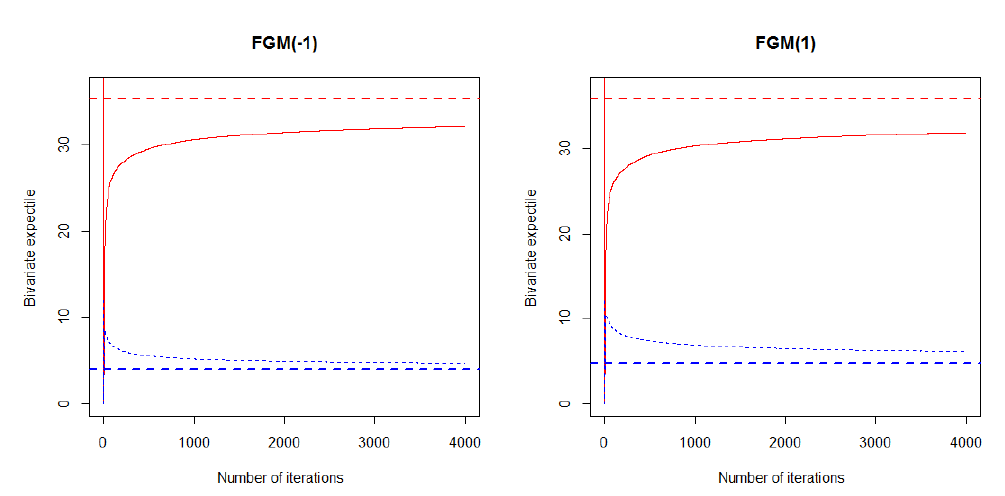
Figure 8: Convergence of the algorithm: L 1 − expectile α = 0.85 , FGM model (left θ = −1 , right θ = 1 , red β 1 = 0.05 , blue β 2 = 0.25